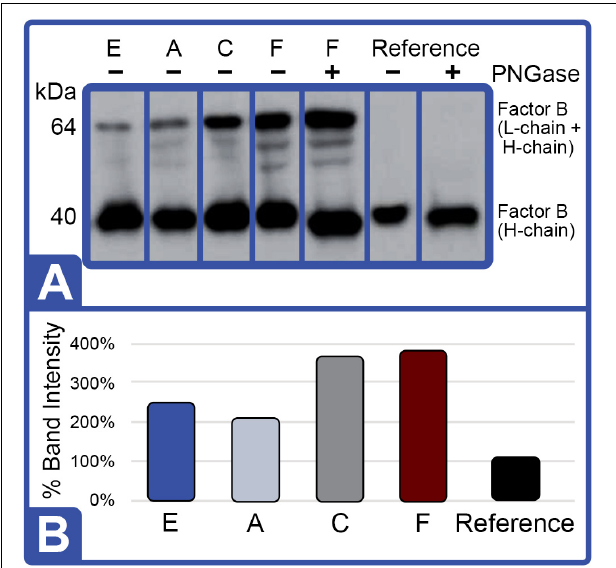
FIGURE 7 | Effect of diet on Factor B protein expression (Feed Study 3). (A) Western blot of crude lysates (5 µ g) of LAL from each diet analyzed vs. reference LAL. Extracts from Diet E (Lane 1), Diet A (Lane 2), Diet C (Lane 3), Diet F (Lane 4), Diet F + PNGase (Lane 5), reference LAL (Lane 6), and reference LAL + PNGase (control; Lane 7) with See Blue+2 molecular weight marker. Each sample was resolved across 8.0% Tris-Glycine gel and transferred to PVDF membrane. Proteins analyzed by membrane incubation with anti-Factor B polyclonal rabbit antibodies (KLKB1). Both aquaculture (Diet F) and reference LAL revealed Factor B H-chain glycosylation as shown by slight molecular weight shift in Lanes 4 and 5 of aquaculture LAL and Lanes 6 and 7 in reference LAL. Single-chain Factor B (L- + H-chain) was resolved only in the aquaculture LAL (Lanes 1–5 vs. Lanes 6 and 7); it was not sensitive to PNGAse treatment (Lane 4 vs. 5). Activated Factor B (A- and B-chains) was not observed. (B) Total Factor B protein abundance (% band intensity) quantified on an imaging device. Ref, reference.